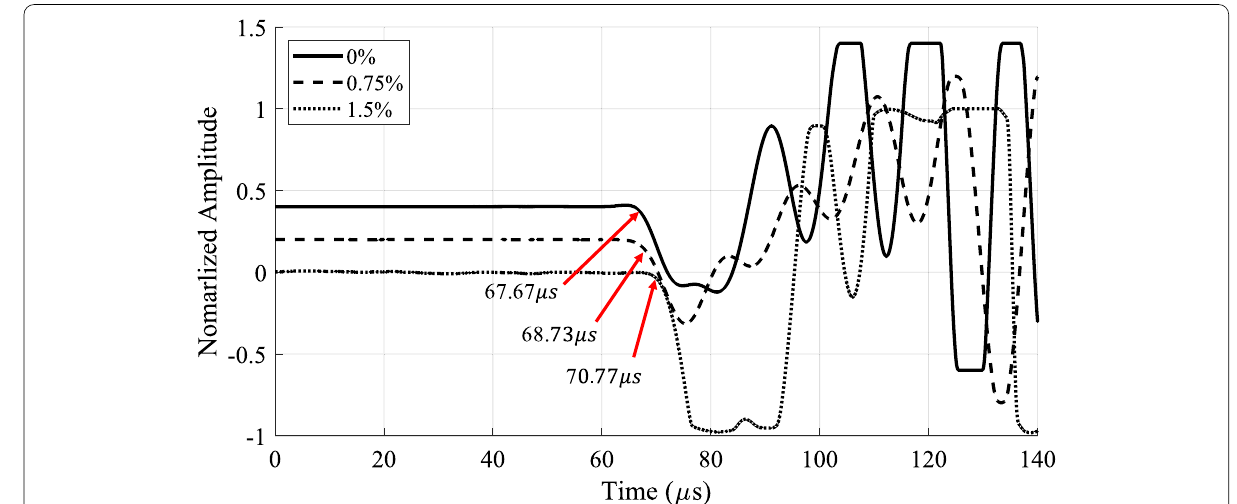
Fig. 9 Waveforms obtained at different drift ratios from the